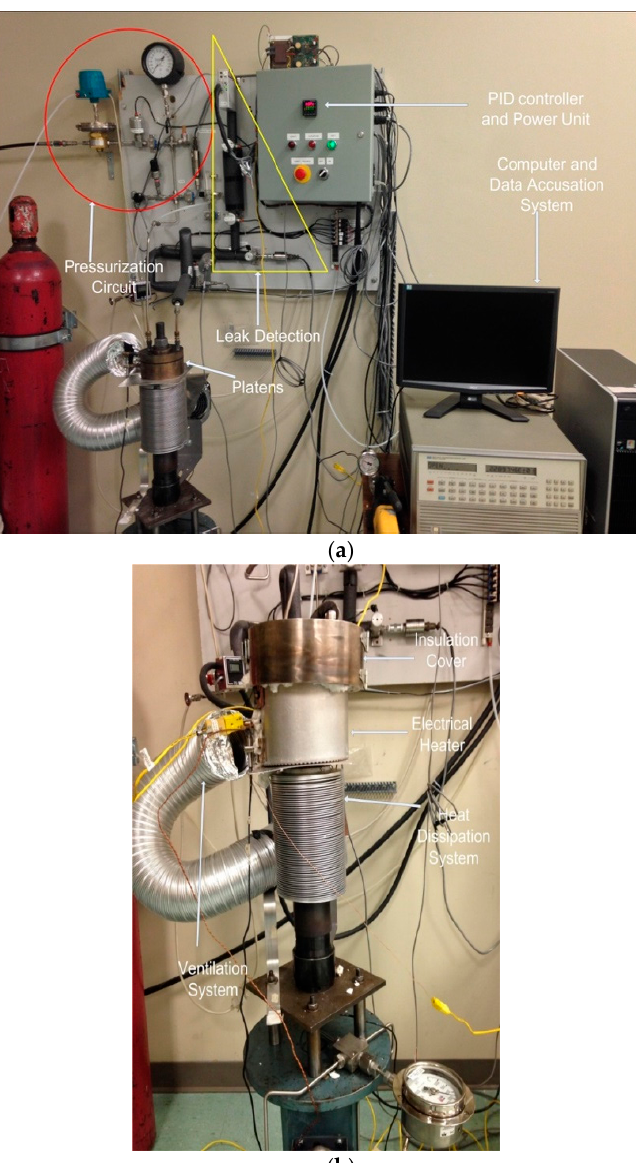
Figure 1. Universal gasket rig: ( a ) entire unit; and ( b ) heating system.